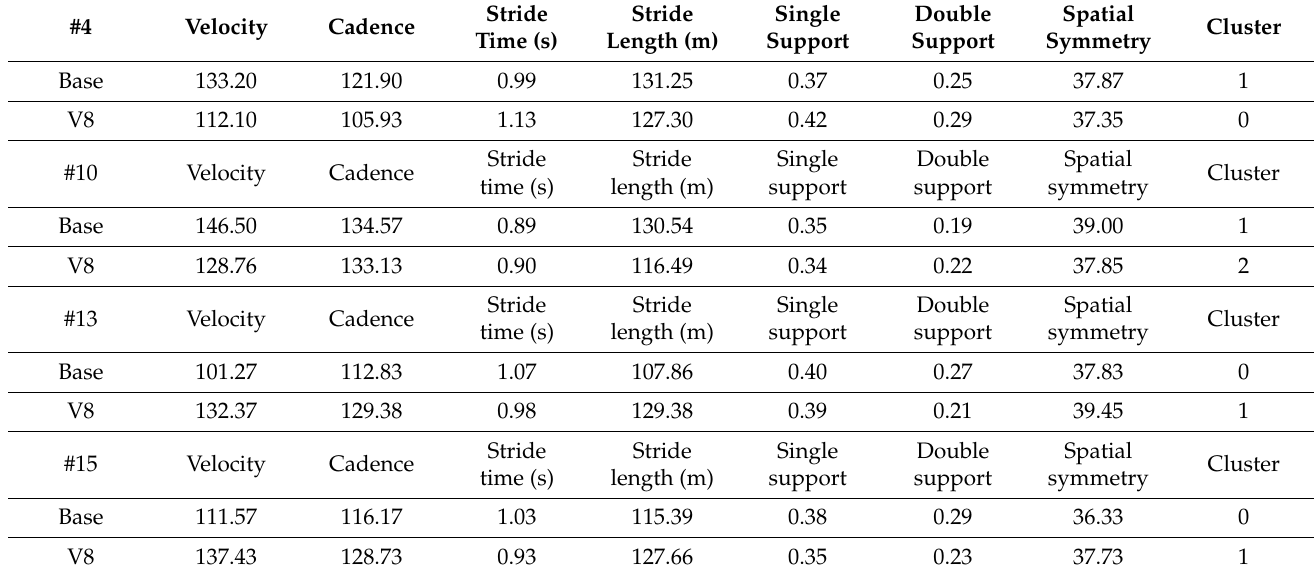
Table 5. Gait parameter changes during 8 weeks for four participants with changed